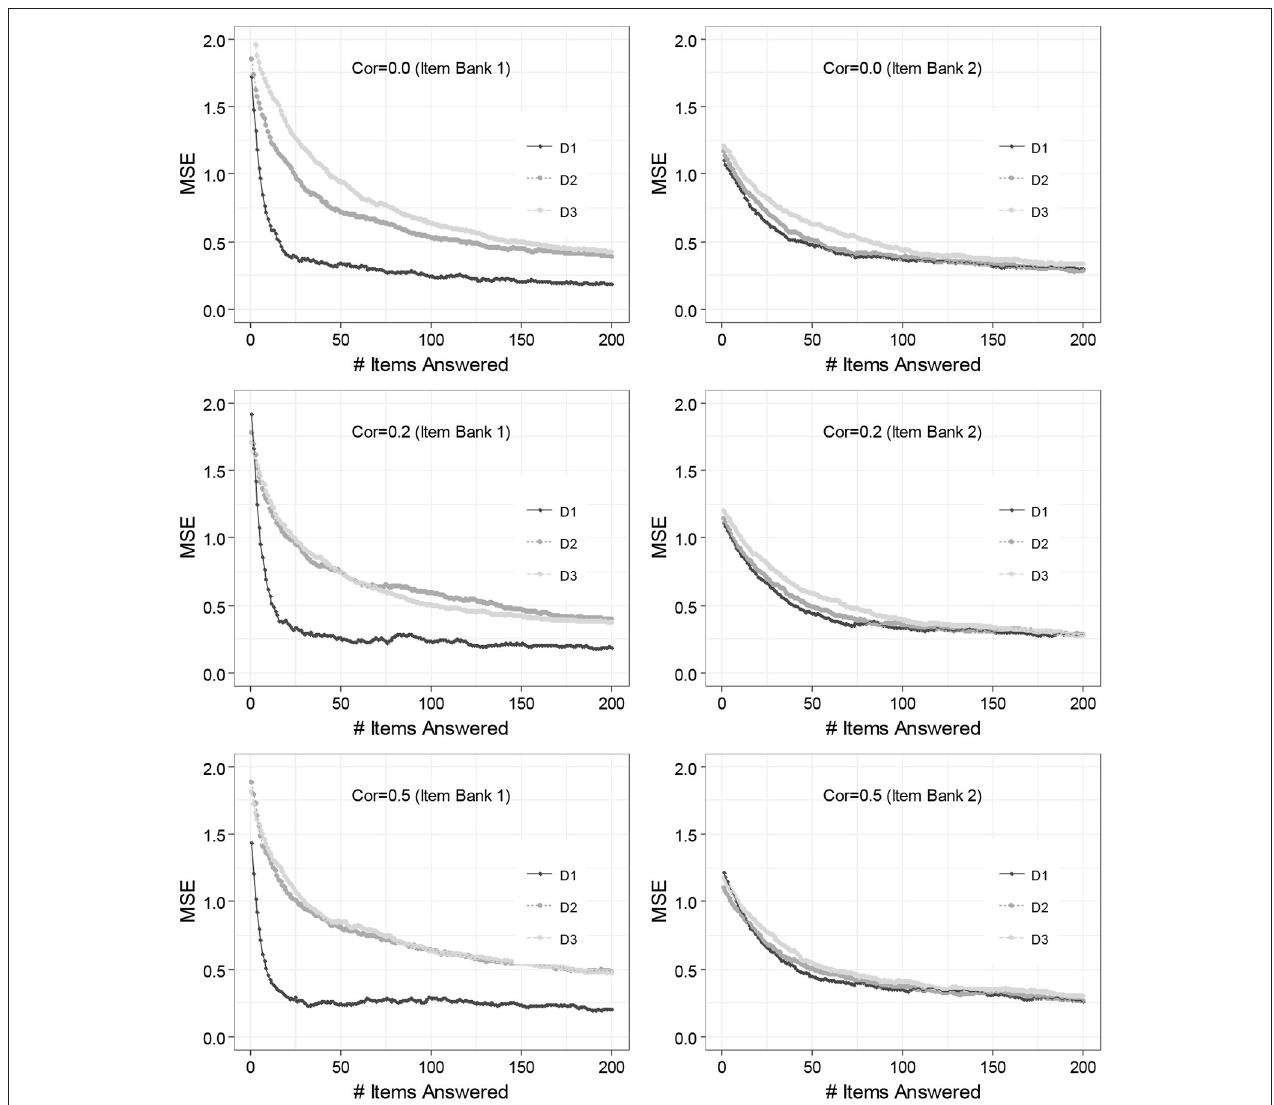
Figure 2 includes line plots demonstrating the performances of other three on the right-hand side are based on the data where each item involves only a single dimension. See the section the M-ERS for two different patterns of dimensionality. Each panel in the figure represents a different simulation condition with the patterns of dimensionality (Item banks 1 and 2) and the true correlations among ability parameters ( ρ mm ′ = 0.0, 0.2, and 0.5), with a total number of items answered being on the x-axis and the MSEs on the y-axis. The three lines in each panel comprise the squared difference between the ˆ θ im ( t ) and = 250 individual learners for the three θ im ( t ) averaged across n dimensions (“D1,” “D2,” and “D3” in the legend). Remind that the three panels on the left-hand side summarize the performance of the M-ERS method for Item bank 1 that exhibits one primary dimensions plus two auxiliary dimensions (Item bank 1). The